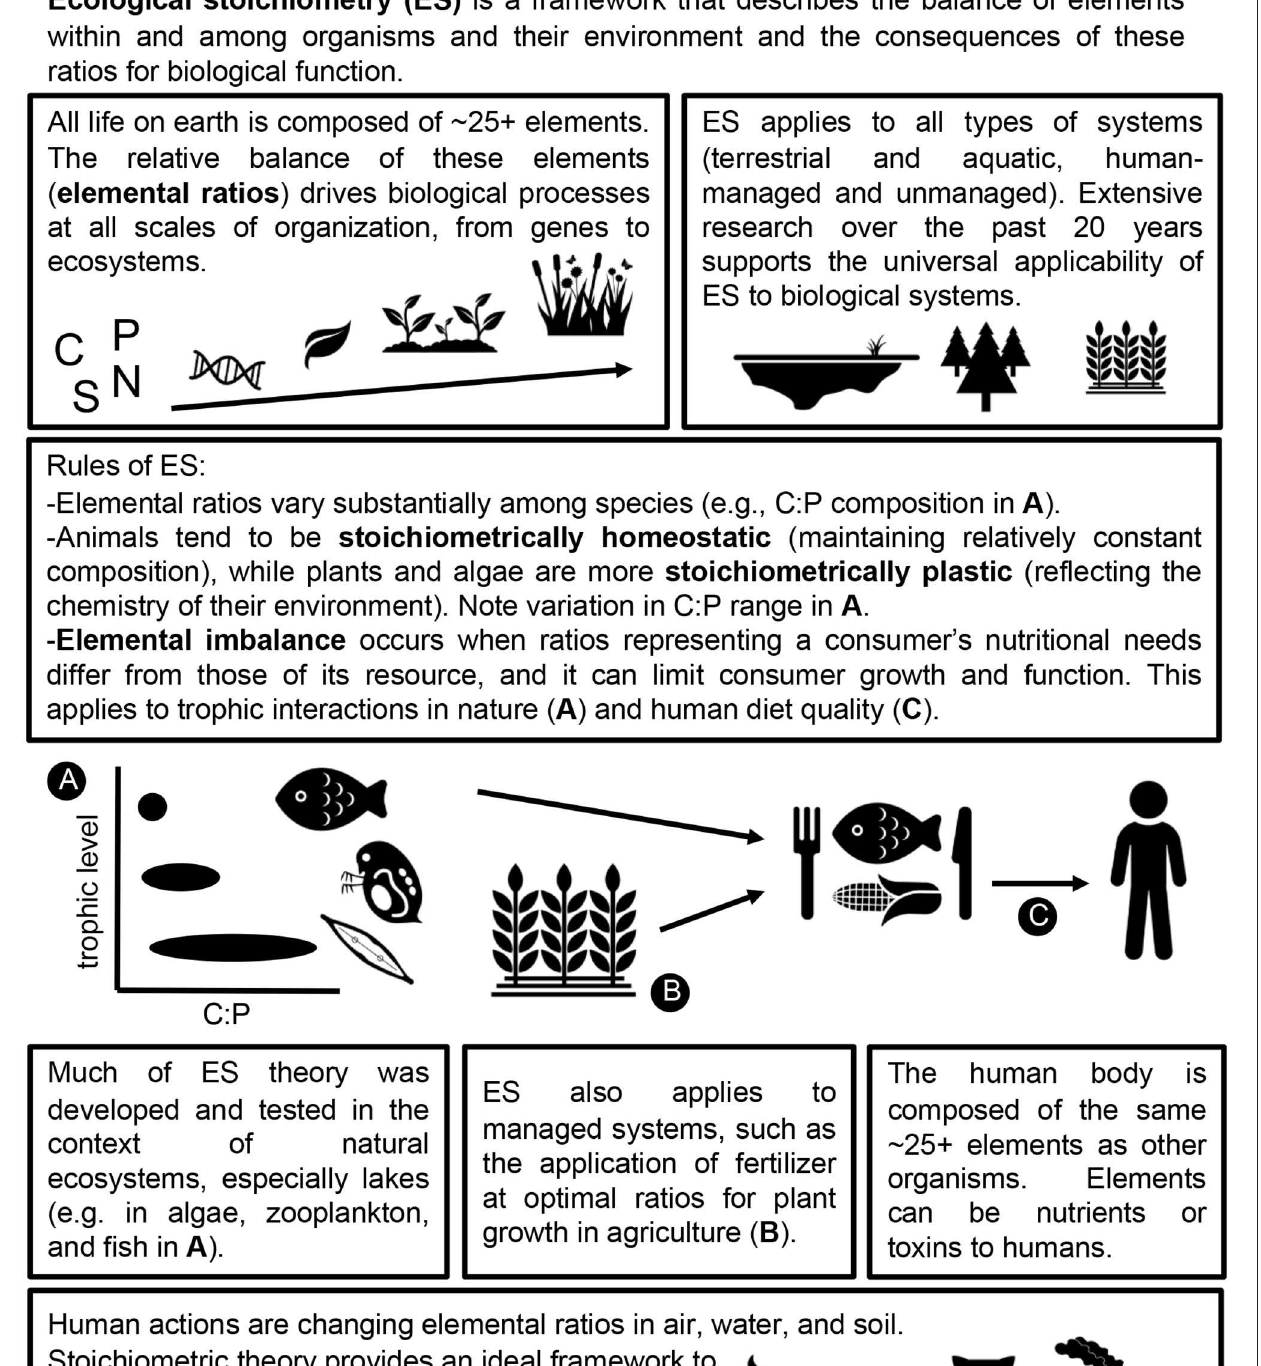
Frontiers in Ecology and Evolution | www.frontiersin.org